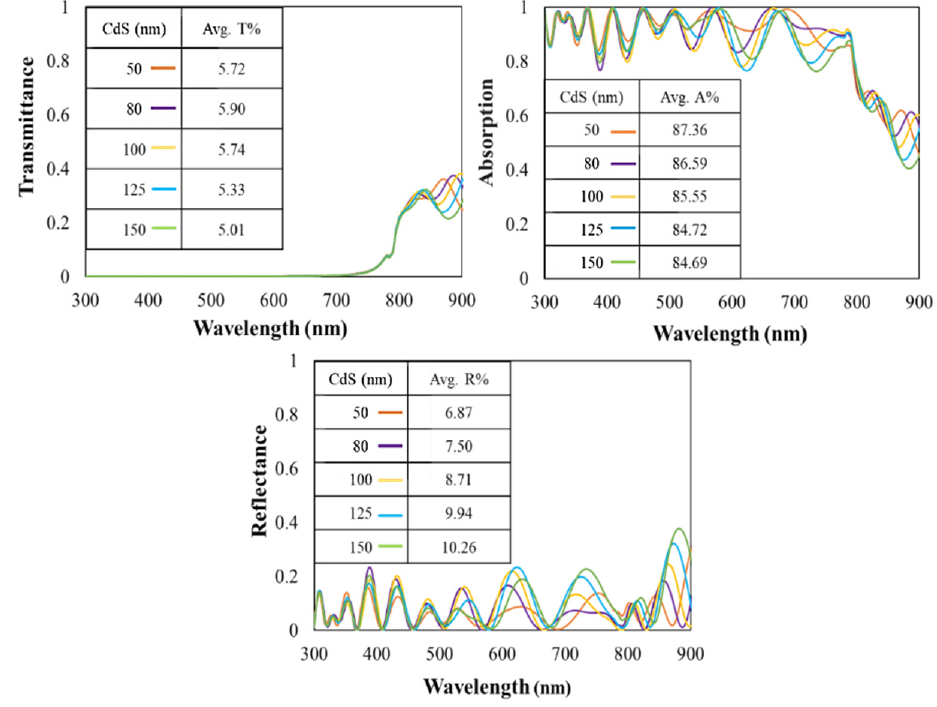
Figure 11. Thin film design with an optimum frontal layer using UTG/ITO/CdS/CdTe (2 μ m).